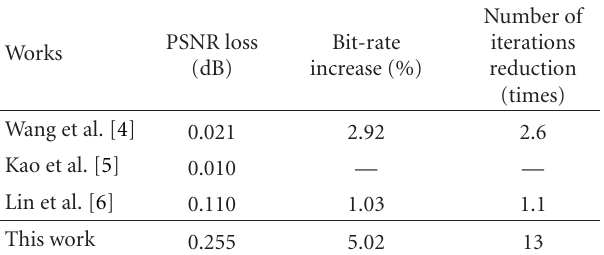
Table 3: Comparison with related